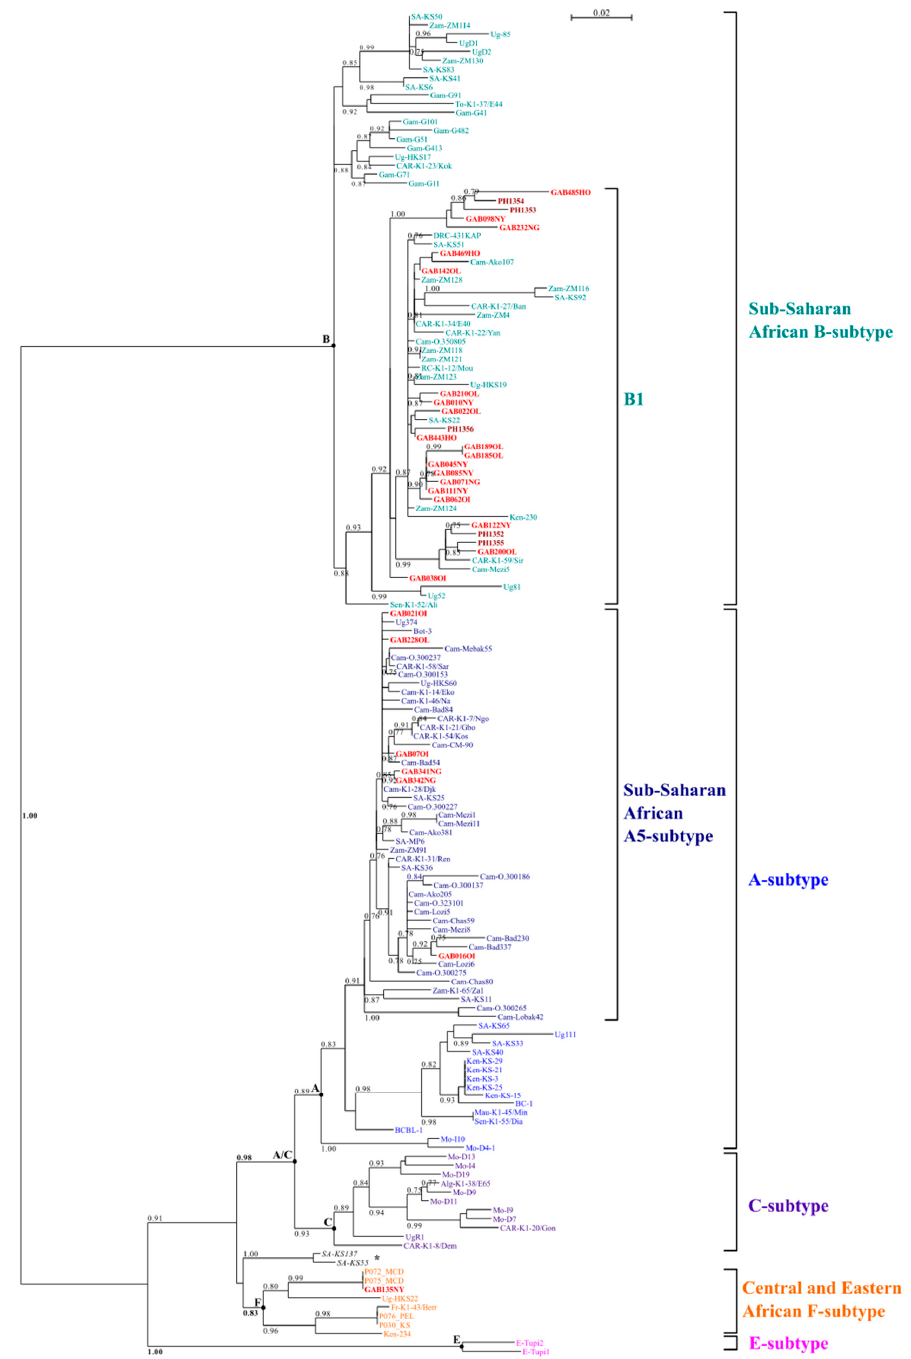
Figure 2. Phylogenetic analysis of the 31 new Kaposi’s sarcoma-associated herpesvirus (KSHV)/HHV-8 sequences. Phylogenetic comparisons were performed with the 689 nucleotide long K1 gene fragment obtained from 153 KSHV/HHV-8 isolates, including the 31 sequences generated in this study (in red) and 122 previously published sequences. The phylogeny was derived by the maximum likelihood (ML) method with the GTR model. Horizontal branch lengths are drawn to scale, with the bar indicating 0.02 nucleotide replacements per site. The maximum posterior probabilities were calculated and reported on the branches with threshold value ≥ 0.75. * Two strains characterized from South Africa (KS55 and KS137) are not yet molecularly classified [34].